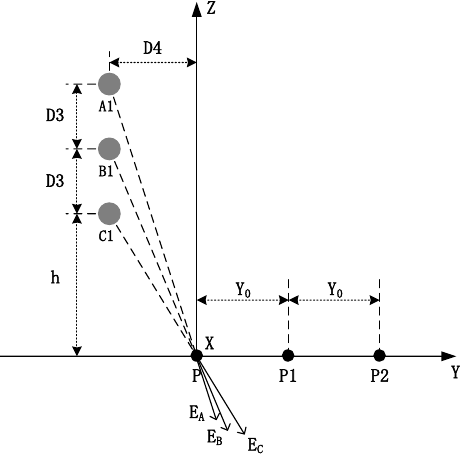
Figure 23. Vertical arrangement of a three-phase wire.